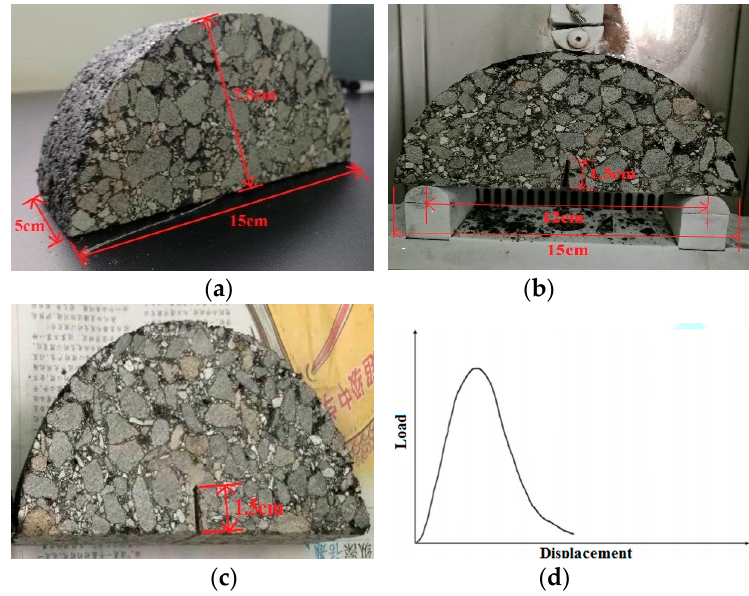
Figure 1. ( a ) Sample dimensions; ( b ) semi-circular bending (SCB) test configuration; ( c ) samples with a notch depth; ( d ) typical SCB load versus displacement ( P - u ) curve.